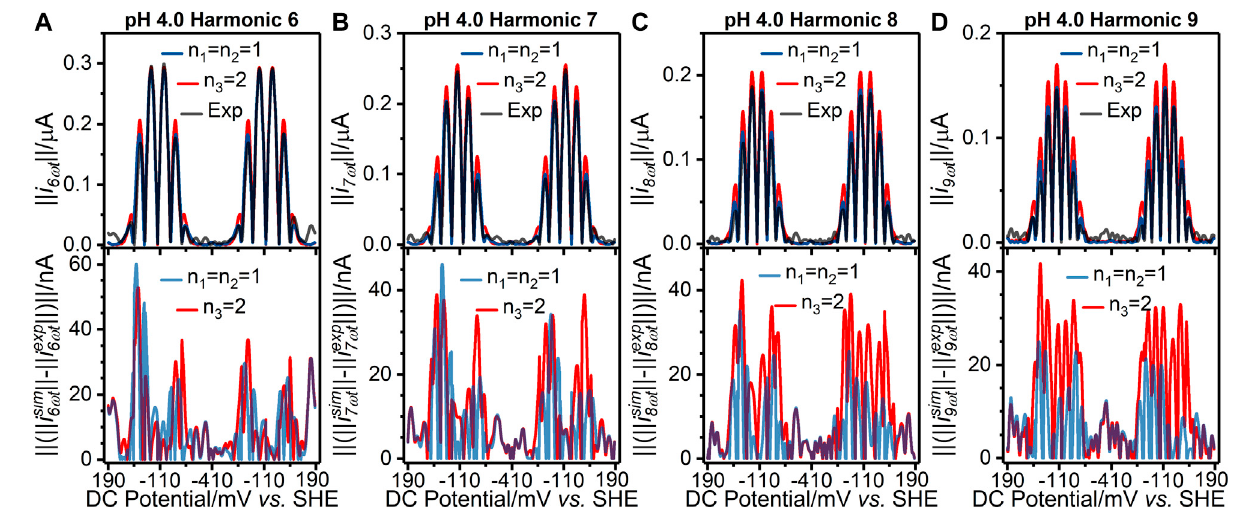
FIGURE 2 | [ (A – D) top panels] Current-potential plots of harmonics six to nine of (grey line) pH 4.0 experiment 3 ( “ Exp ” ) data and best fi t simulated data using (red line)aconcertedtwo-electron( n 3 (cid:2) 2)electrontransfermodeland(blueline)astepwisetwo-sequentialone-electrontransferreactionmodel( n 1 (cid:2) n 2 (cid:2) 1).(Bottompanels) Residual current-potential plots corresponding to the panel above. The parameter values used to generate the simulations are reported in Table 1 , Supplementary Tables S3, S4